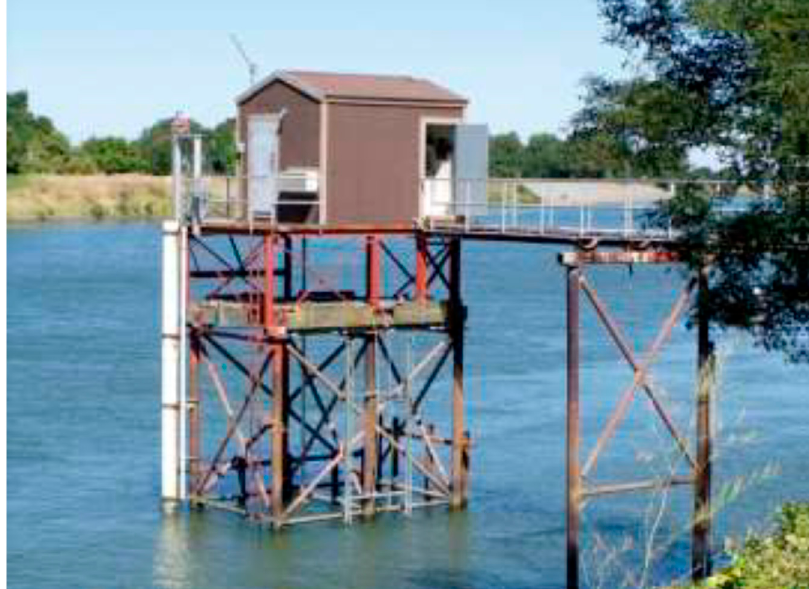
Figure A3. Survey results from 14 water contractors on how they use MWQI real time and forecast data in their regular operations.